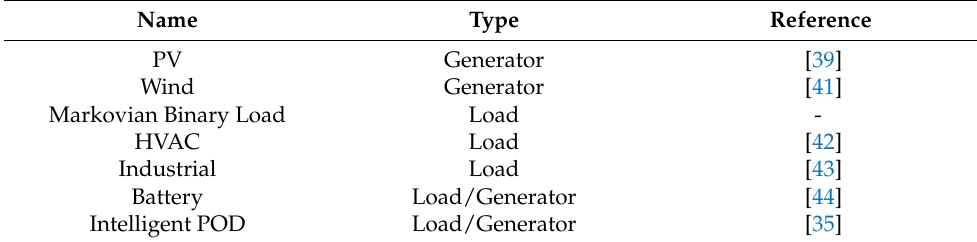
Table 1. Components currently modeled in the